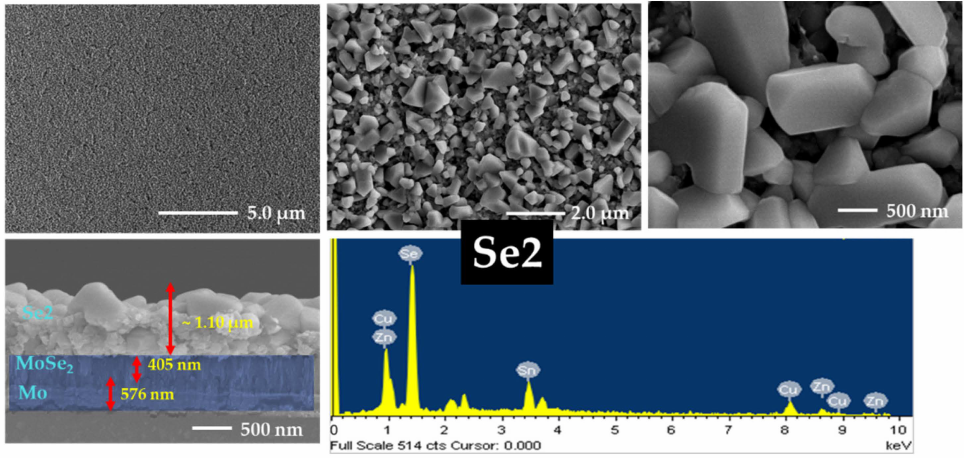
Figure 6. Surface and cross-section images and EDS spectra of Se2 thin